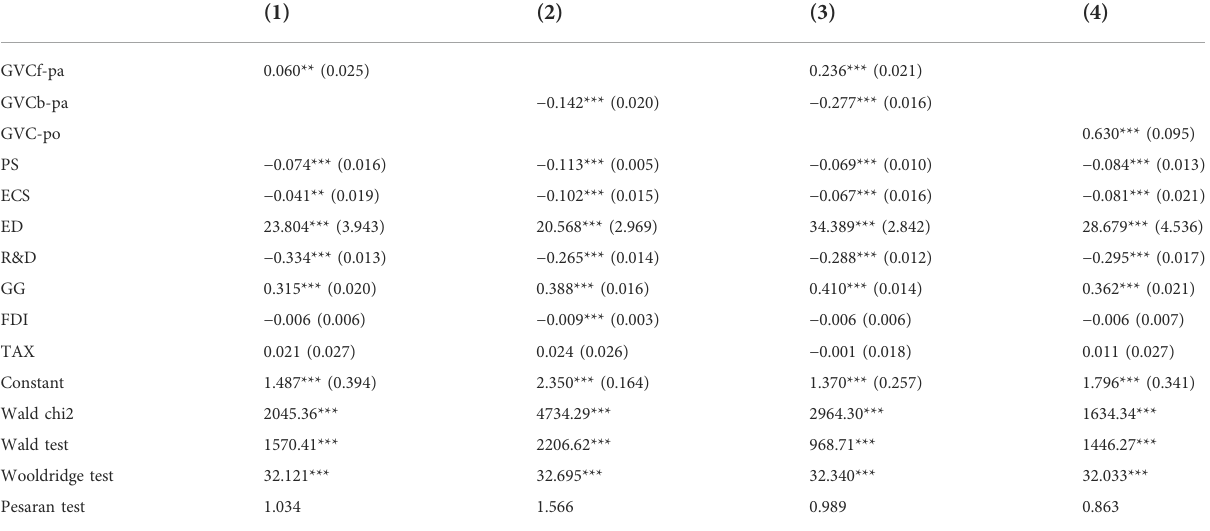
TABLE 4 Benchmark estimation.